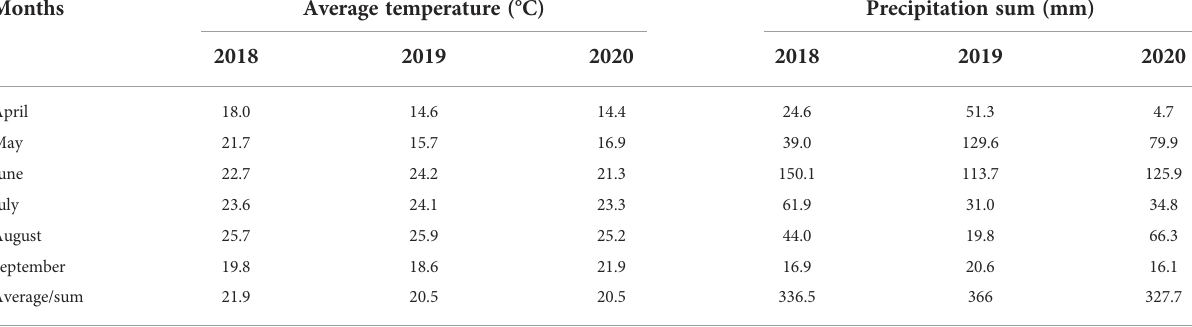
TABLE 2 The mean temperature (°C) and precipitation sum (mm) at Zemun Polje during the maize growing period in 2018 –